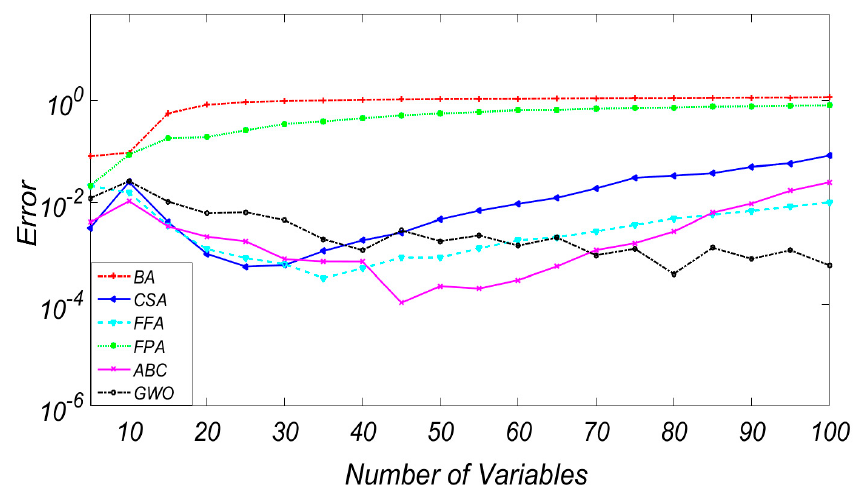
Figure 9. Error vs. variable number for Griewank function ( f 7 ).